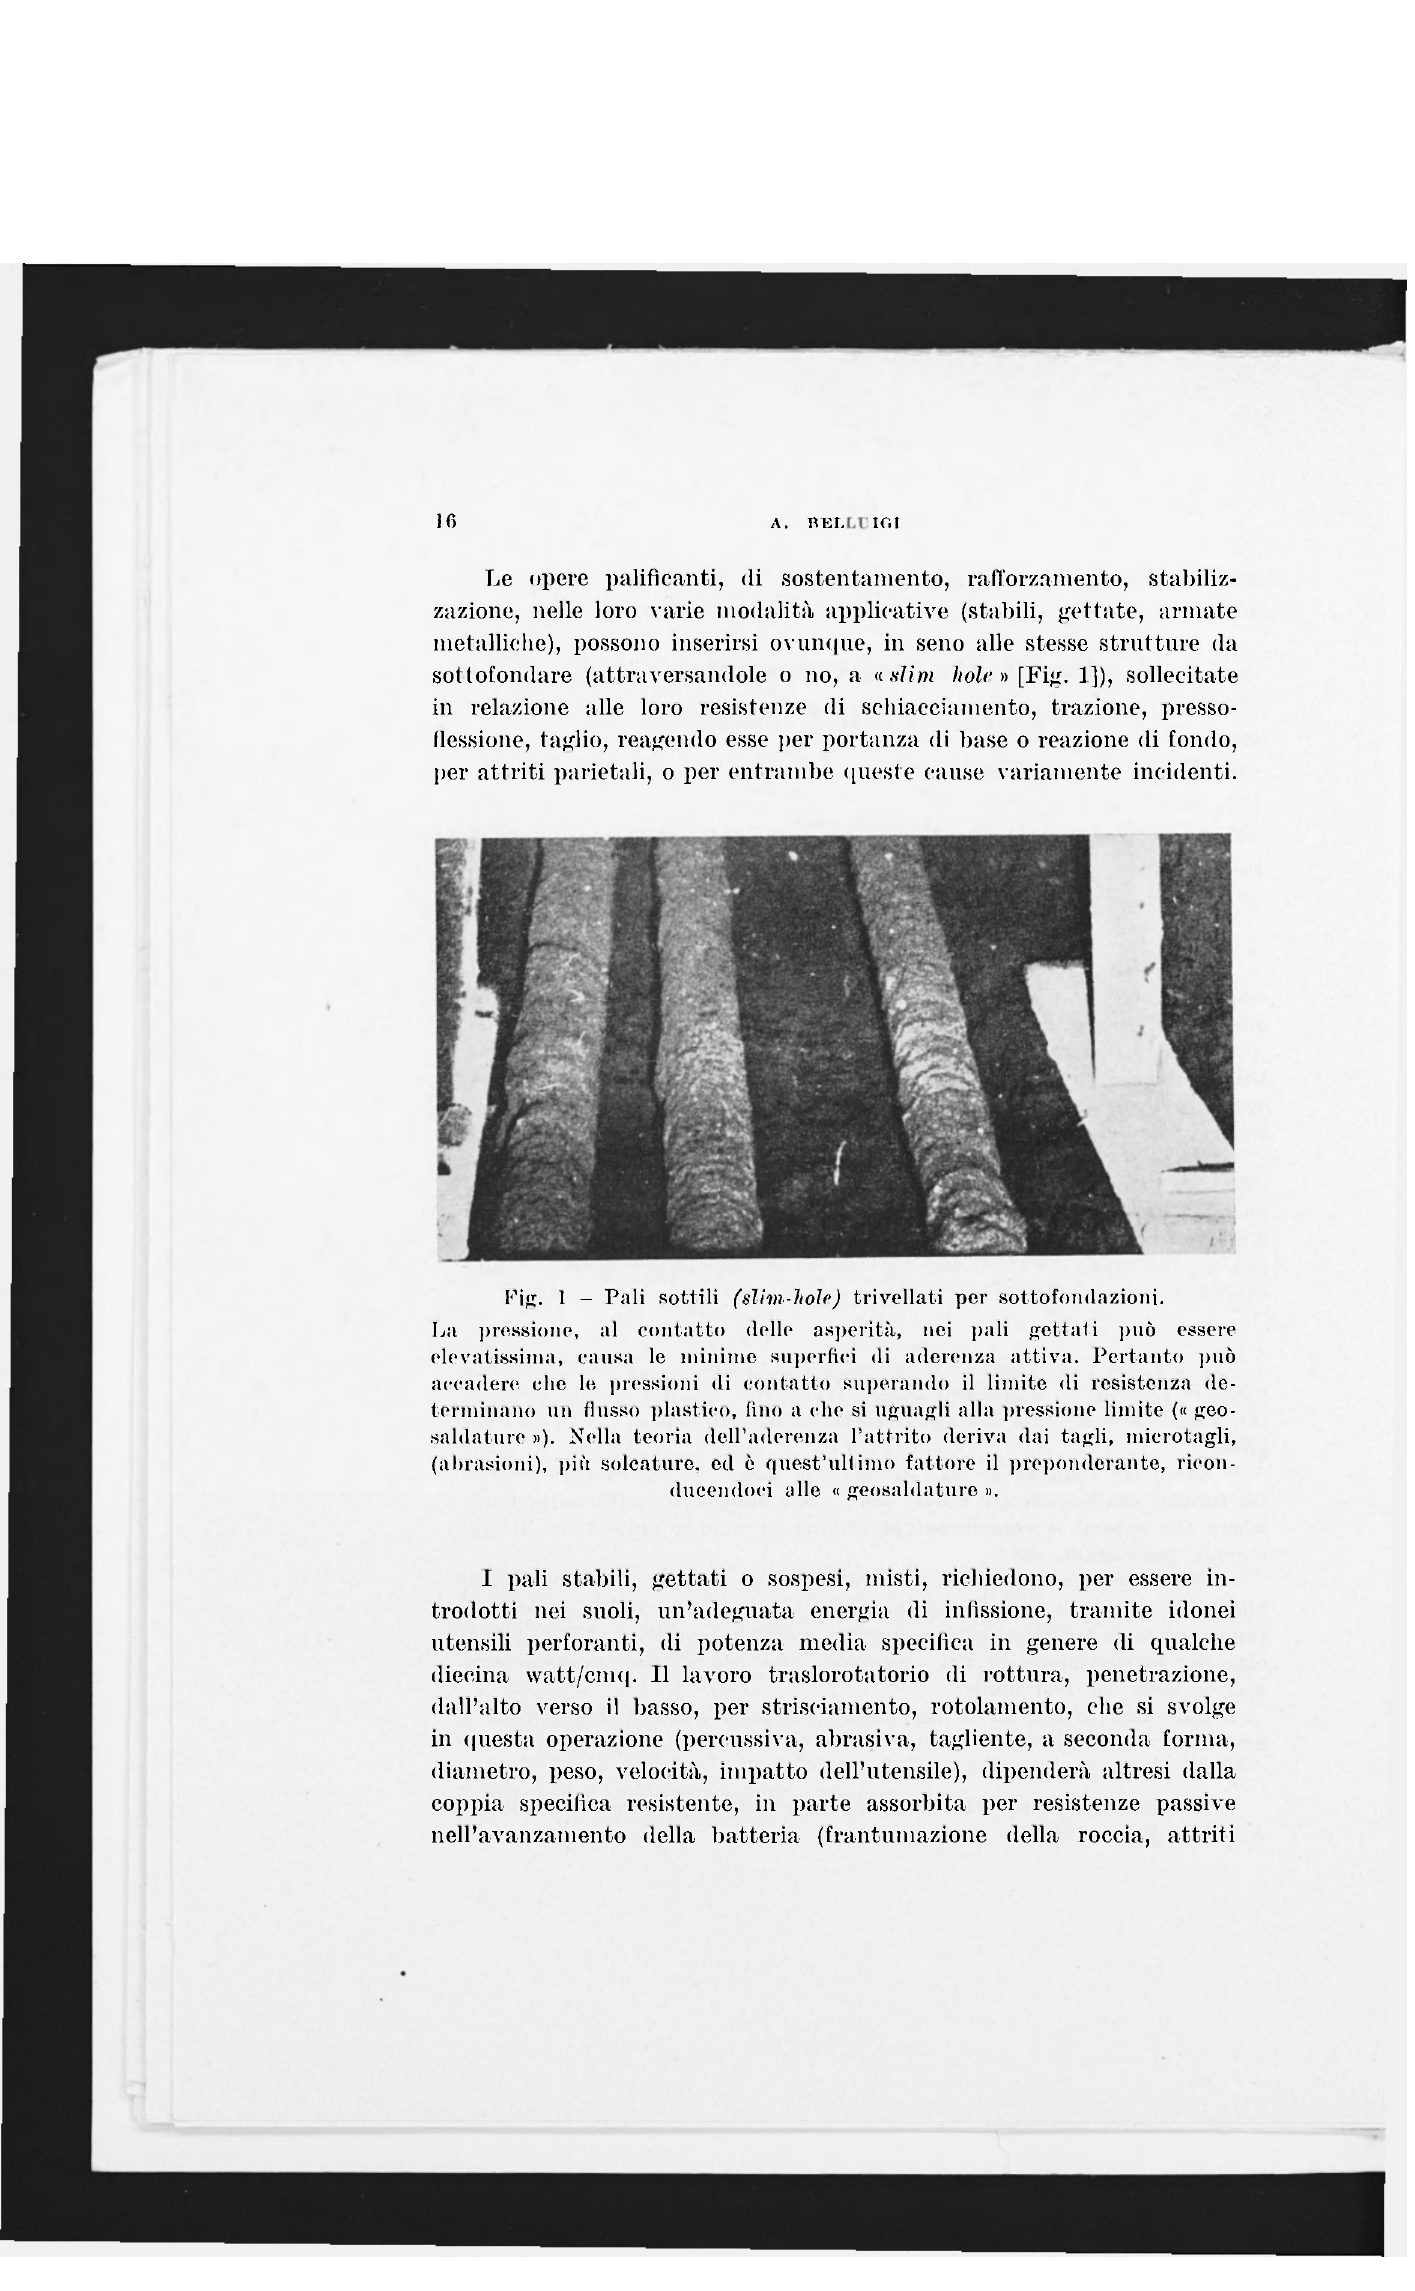
Fig. 1 - Pali sottili (slim-hole) trivellati per